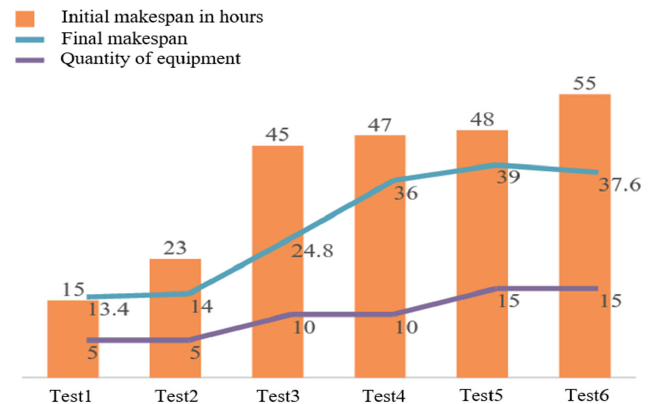
Figure 4. Comparison of the makespan obtained by the test set.